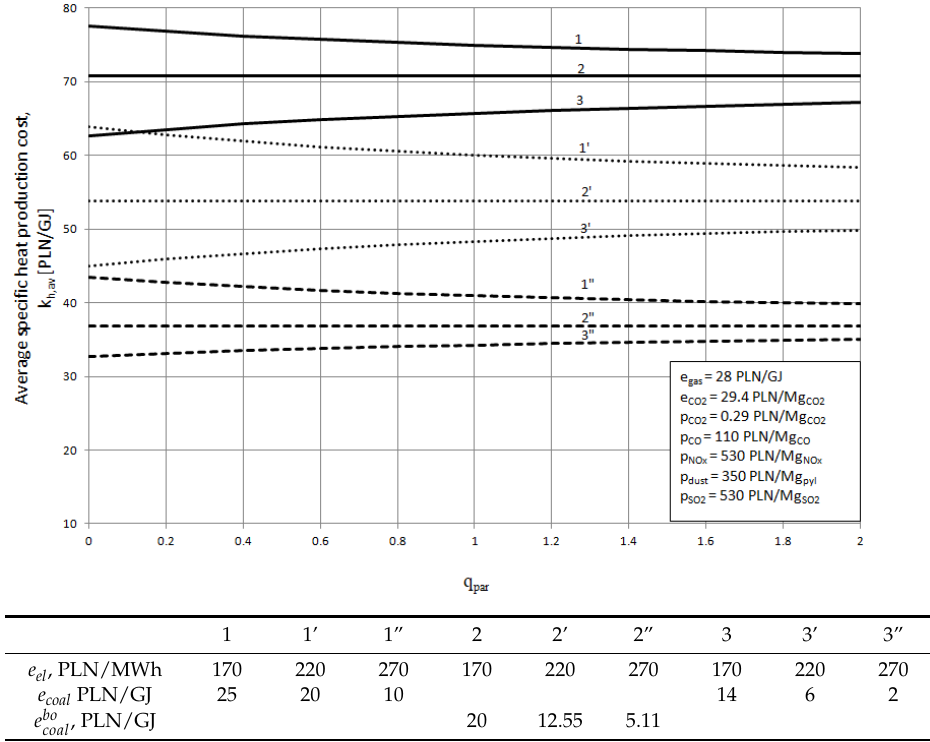
Figure 4. Mean specific cost of heat production as a function of q par with the price of coal as the